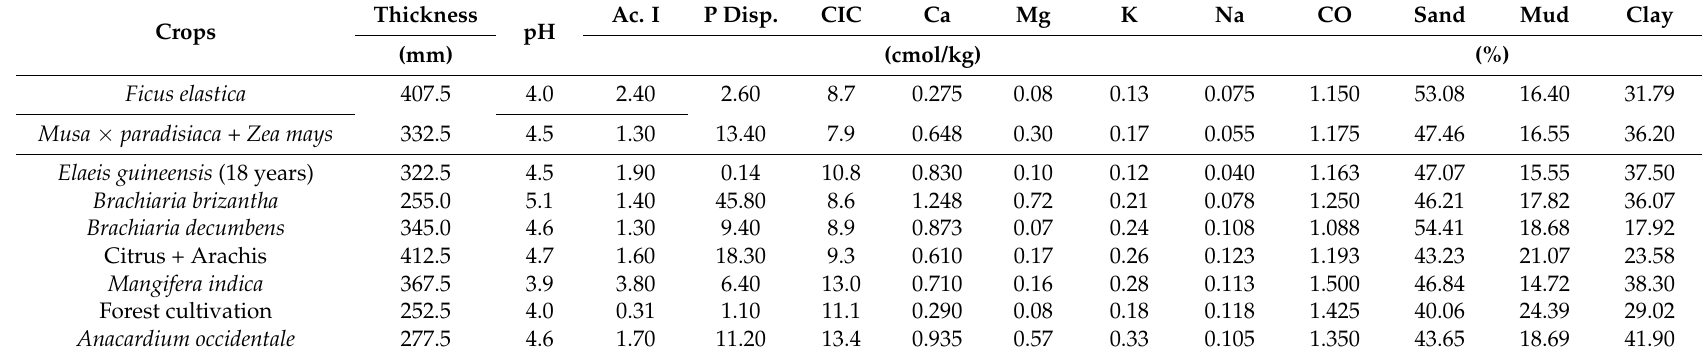
Table 2. Thickness, pH, exchangeable acidity, available phosphorus calcium, magnesium, potassium, sodium, organic carbon, sand, lime, and clay of horizon A.